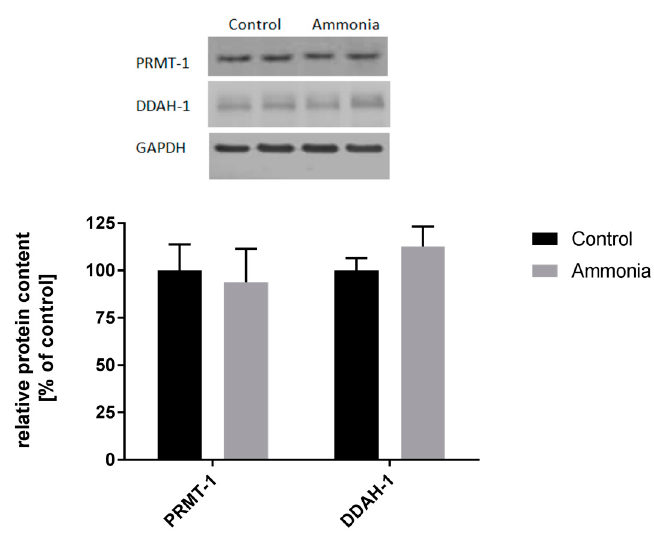
Figure 3. PRMT-1 and DDAH-1 protein level in primary astrocytes treated with 5 mM ammonia for 48 h. Upper panel shows representative Western blots.